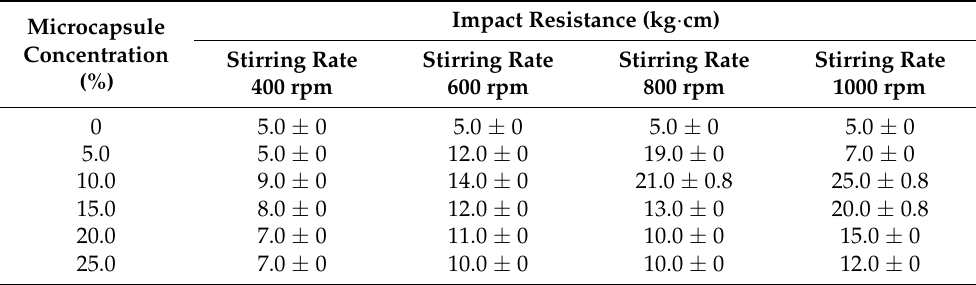
Table 5. Effect of concentration of microcapsules with different stirring rates on impact resistance of waterborne primer film.